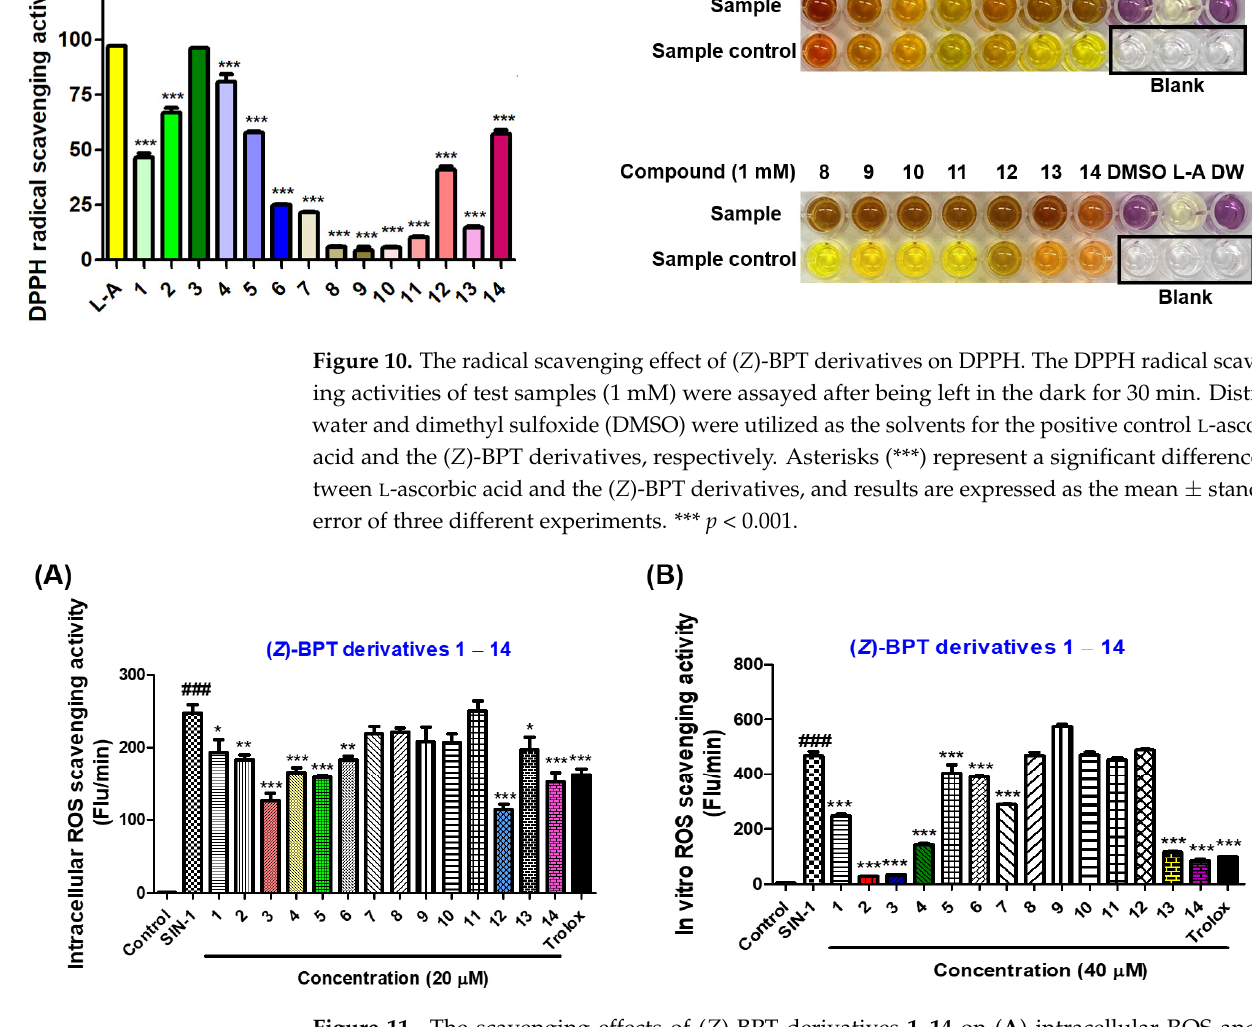
Figure 11. The scavenging effects of ( Z )-BPT derivatives 1 – 14 on ( A ) intracellular ROS and ( B ) in vitro ROS. ROS levels were assessed using an assay with SIN-1 (an ROS generator) and DCFH-DA (an ROS-sensitive fluorescence probe). To induce ROS generation, 10 µ M of SIN-1 was used. For the intracellular ROS scavenging activity and in vitro ROS scavenging activity, the concentrations of ( Z )-BPT derivatives utilized were 20 µ M and 40 µ M, respectively. B16F10 cells were used for intracellular ROS scavenging experiments, and Trolox was used as a positive reference material in both ROS scavenging experiments. ### p < 0.001 for SIN-1-treated cells ( A ) or SIN-1-treated